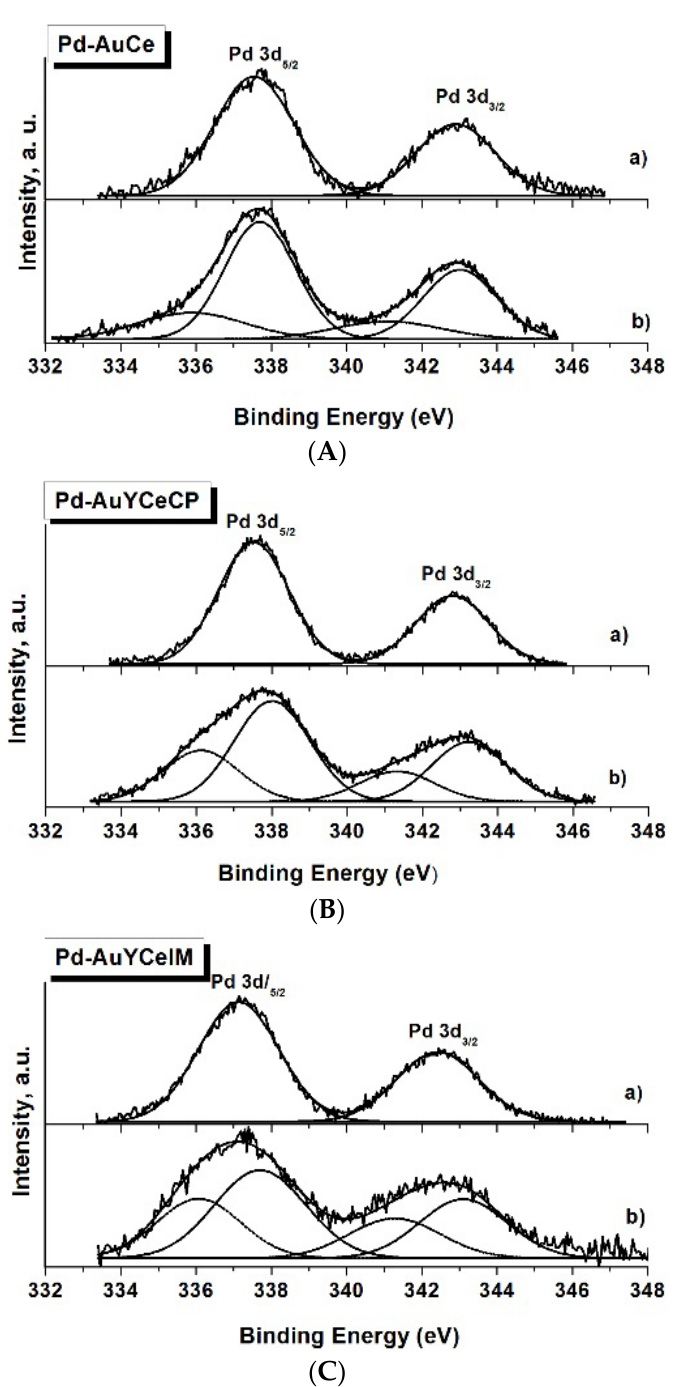
Figure 6. Pd 3d XP spectra of ( A ) Pd–AuCe catalyst as: (a) fresh and (b) after CBO; ( B ) Pd–AuYCeCP catalyst as: (a) fresh and (b) after CBO; ( C ) Pd–AuYCeIM catalyst as: (a) fresh and (b) after CBO.